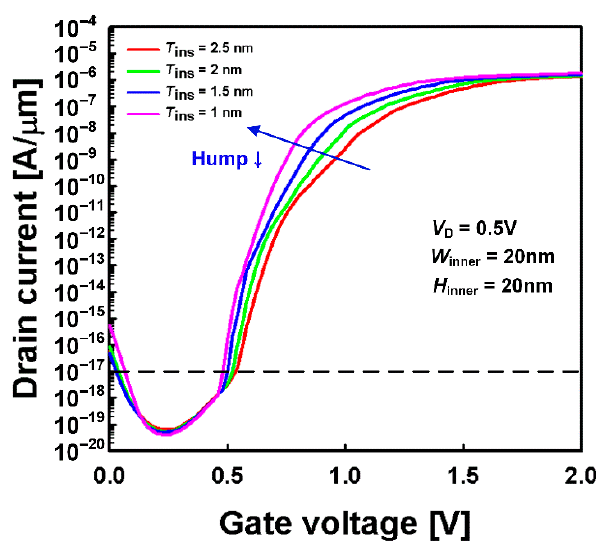
Figure 12. Transfer characteristics of NW gate-normal TFETs with the variation in thickness of gate insulator ( T ins ).